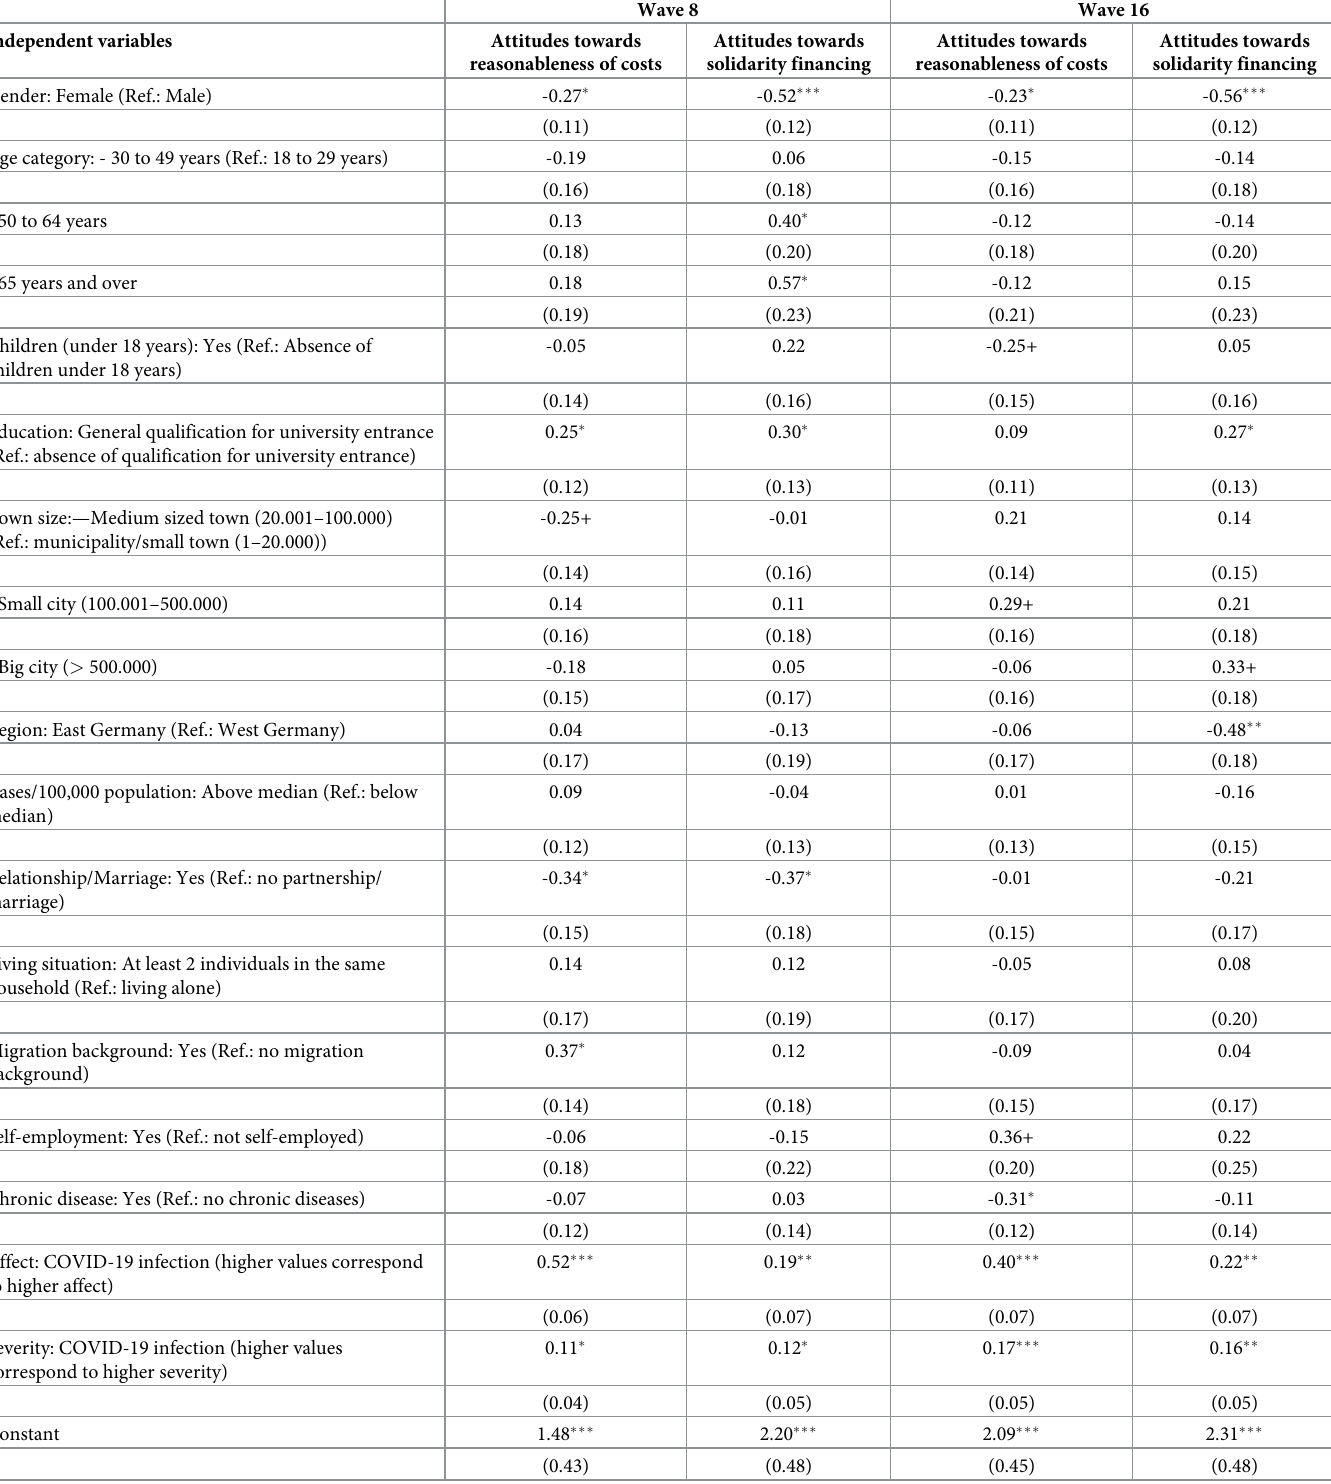
Table 2. Determinants of attitudes towards reasonableness of economic costs (column 2 and column 4) and solidarity financing (column 3 and column 5). Results of multiple linear